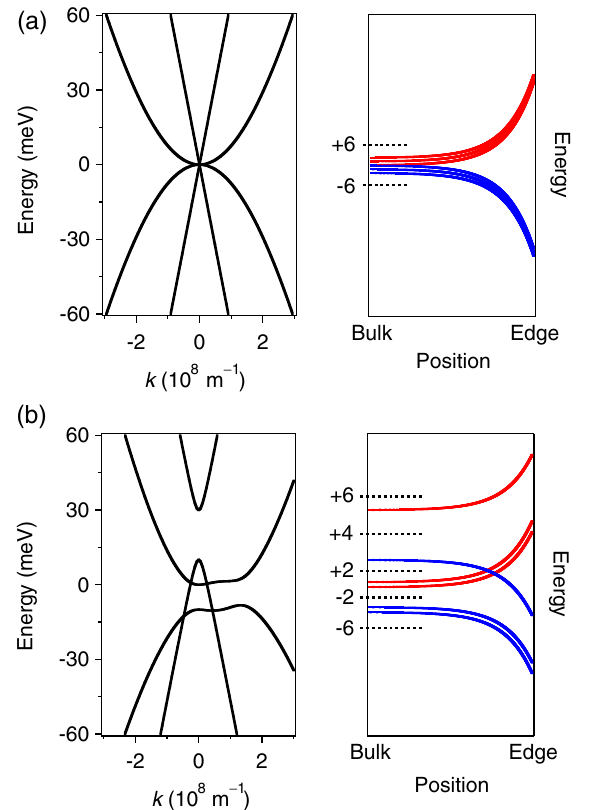
FIG. 4. (a) The band structure of the 1 þ 2 model of ABA- stacked trilayer graphene (left) and the associated lowest LLs (right). QH plateaus occur when the Fermi level lies at the dashed lines, with quantum number þ 6 ( (cid:1) 6 ) when all levels are full (empty). (b) Band structure calculated to higher order in the Slonczewski-Weiss-McClure model (see text). Two bands overlap atzeroenergy,creatingasemimetal.Totheright,thecorresponding lowest LLs allow for additional QH plateaus at (cid:1) 2 , þ 2 , and þ 4 . Level energies are plotted against position, diverging upward (downward) for electron (hole) states near the sample boundary. AllLLsaretwofolddegeneratefortheelectronspin.Closelyspaced pairs mark only the number of levels, not additional